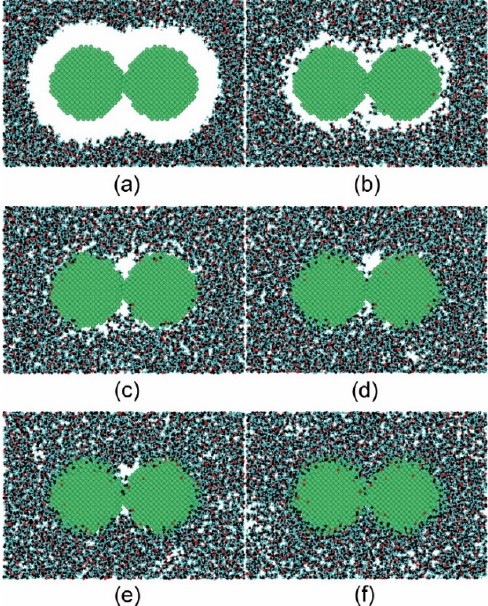
Figure 12. Snapshots of double sphere model at ( a ) 0 ps, ( b ) 2 ps, ( c ) 4 ps, ( d ) 6 ps, ( e ) 8 ps, and ( f ) 15 ps.